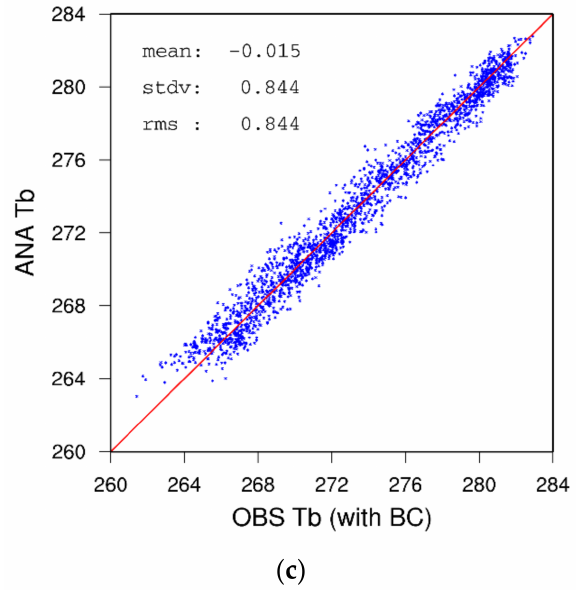
Figure 4. The scatterplots of model-calculated GEOMS versus observed radiances (K) for ( a ) backgrounds before bias correction, ( b ) backgrounds after bias correction, and ( c ) analyses valid at 0000 UTC 06 August